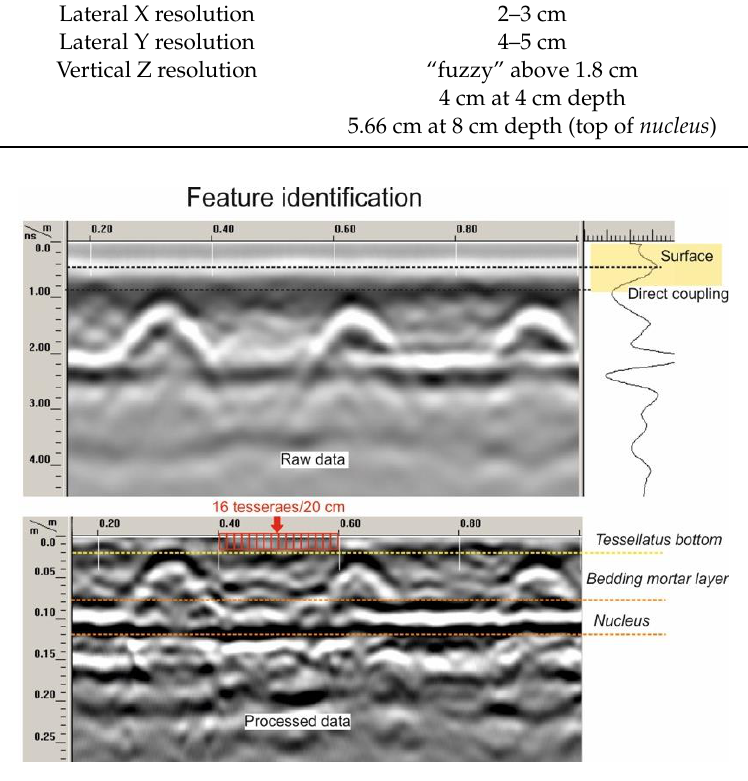
Figure 8. Fragments of acquired radargrams over the mosaic with the 1600 MHz antenna; the fragments contain the main identifiable features. The upper radargram is raw data, and the lower radargram is the same processed data, where we note that the 16 tesserae of the chain represented by the red grid, which fill 20 cm on average, are not detected. The three hyperbolas are caused by the sinopia main furrows.